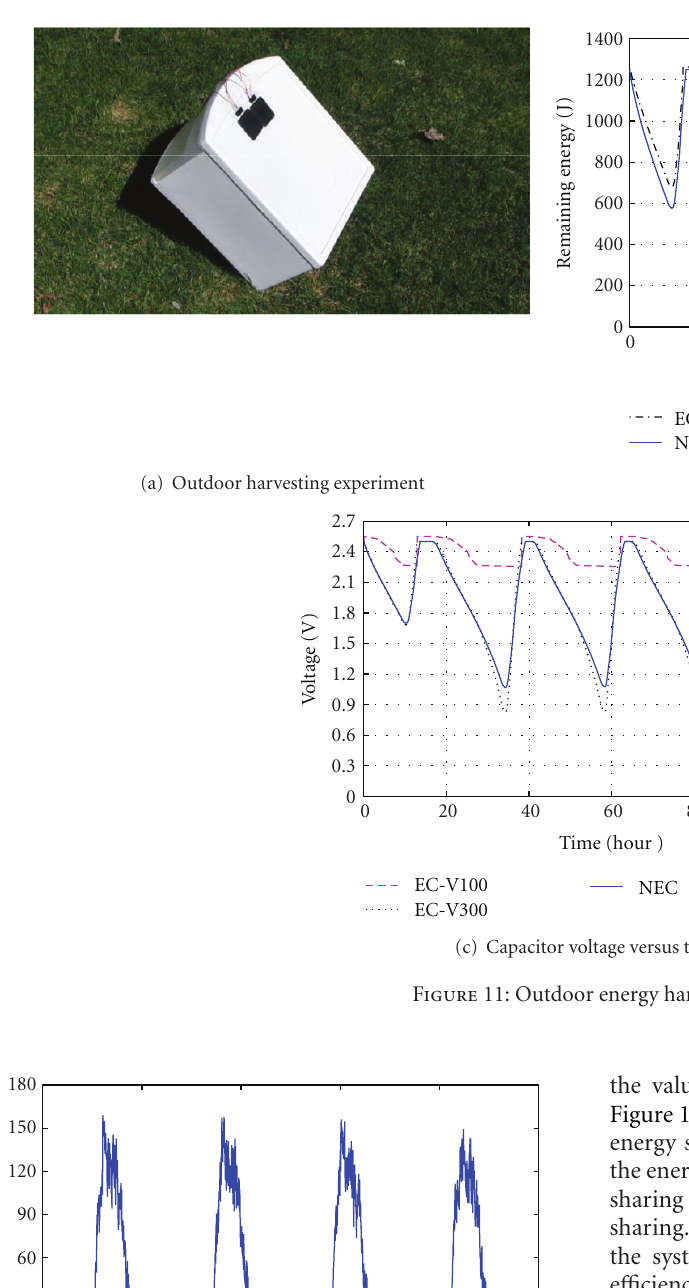
graph represents the averaged value of 10 runs, and the 95% confidence intervals of the data are within 3 ∼ 8% of the mean